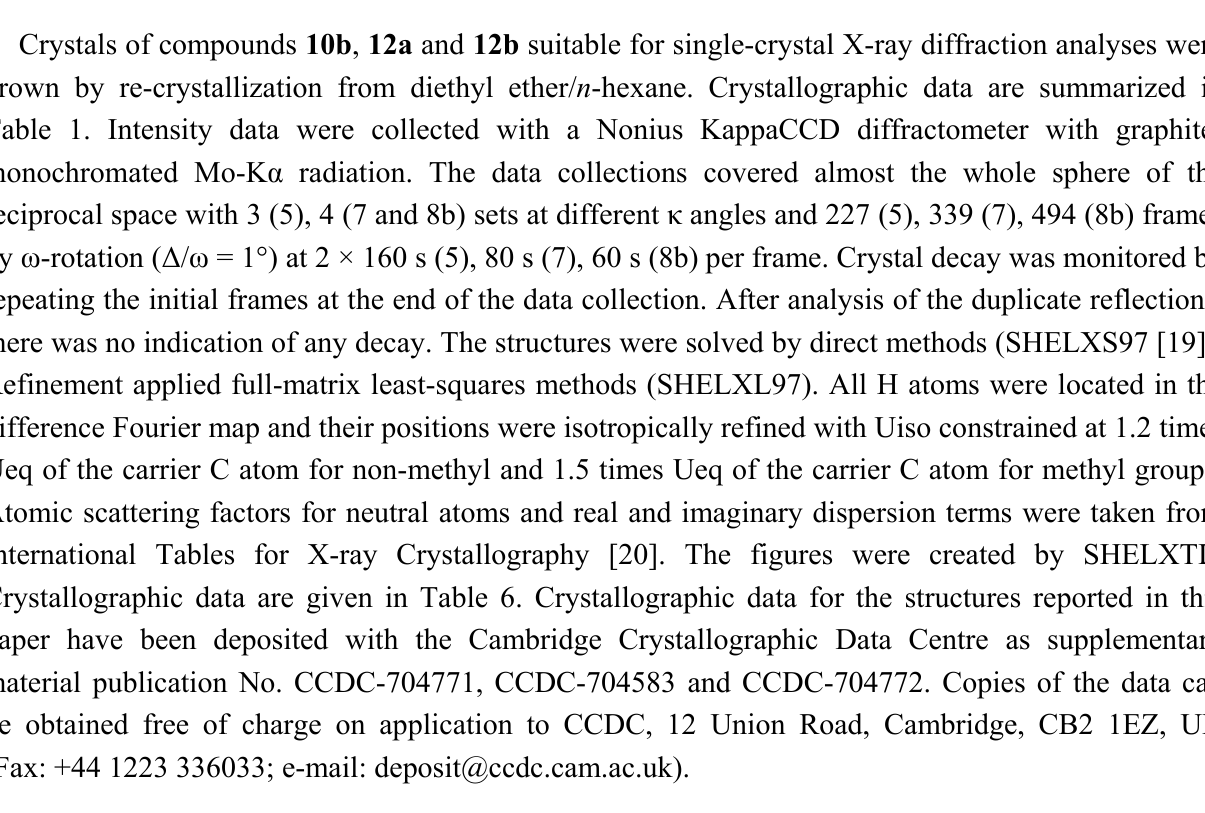
Table 6. Crystallographic data for 10a , 12a and 12b